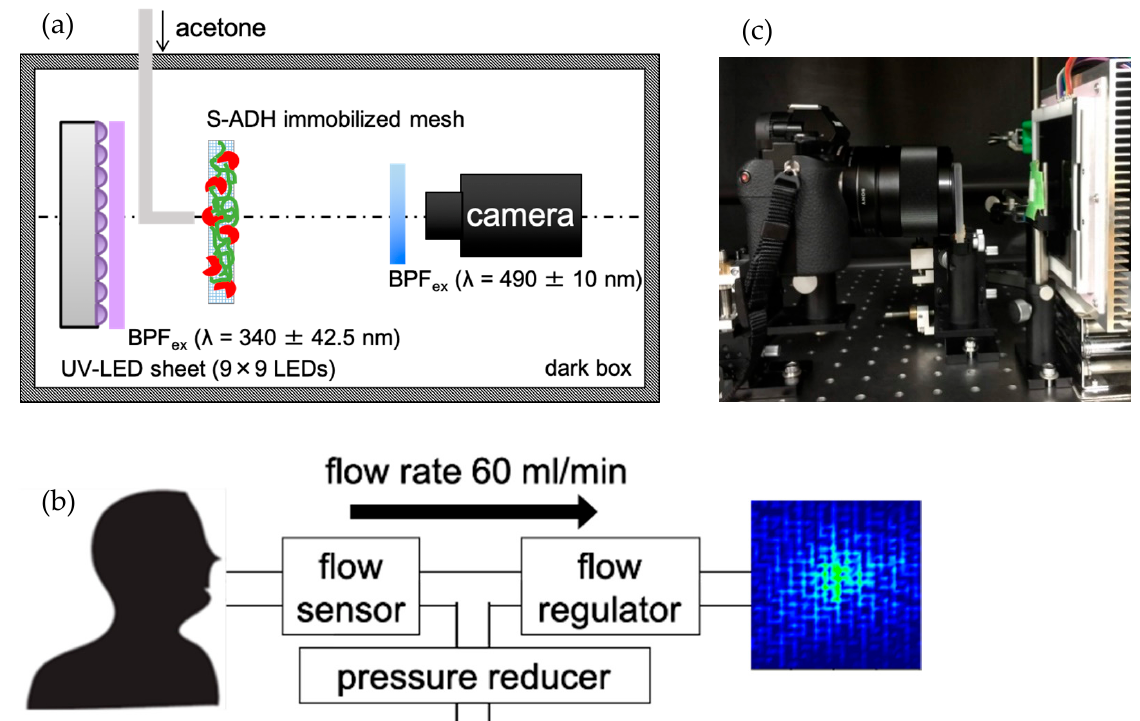
Figure 1. ( a ) Schematic illustration of the acetone gas imaging system using an UV-LED sheet, S-ADH immobilized mesh, and CMOS camera. ( b ) Schematic image of the direct breath gas imaging system using a flow sensor and flow regulator. ( c ) Photograph of the imaging system.